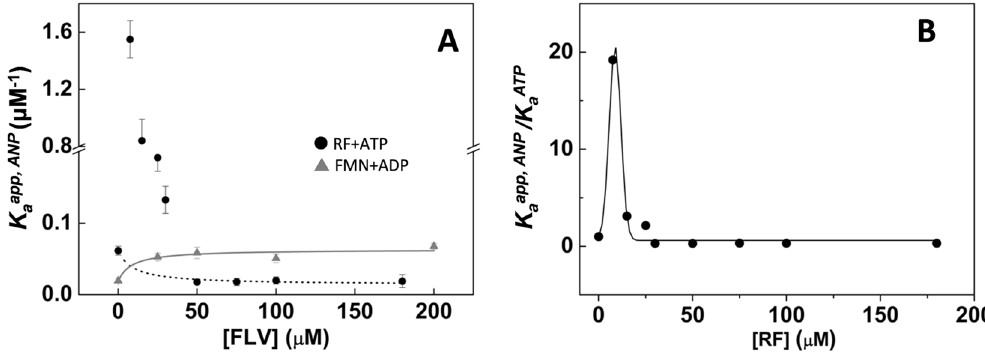
Figure 5. Binding cooperativity of the flavin and adenine nucleotide ligands to the RFK module. ( A ) Dependence of apparent ANP association constants, K aapp ANP , , on the concentration of the flavin ligand for the titration with ATP of mixtures of the RFK module with different amounts of RF ( ● ), as well as for the titration with ADP of mixtures of the RFK module with different amounts of FMN ( ▲ ). Lines show the fits to Eqn. 7 to determine the positive cooperativity between FMN and ADP (grey line) and the negative cooperativity between RF and ATP at RF concentration above 50 µ M (dotted line) 32 . Points at lower RF concentrations are included to provide a view of K aapp ATP , evolution with RF concentration, but since fitting is not possible they are not connected to avoid misinterpretation. ( B ) Evolution of the K K / aapp ATP aATP , ratio as a function of the RF concentration. All experiments were performed in 20 mM PIPES, pH 7.0 at 25 °C. Lines are included only as visual cues for the data evolution.